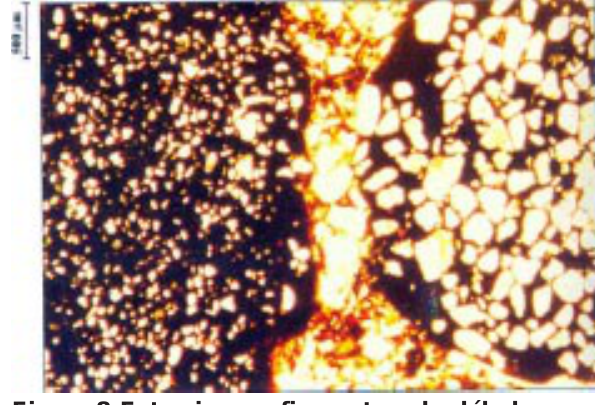
5. Morfologia interna da petroplintita do horizonte F (perfil P2) evidenciando seu completo caráter isótico. Luz normal - 2,5x.